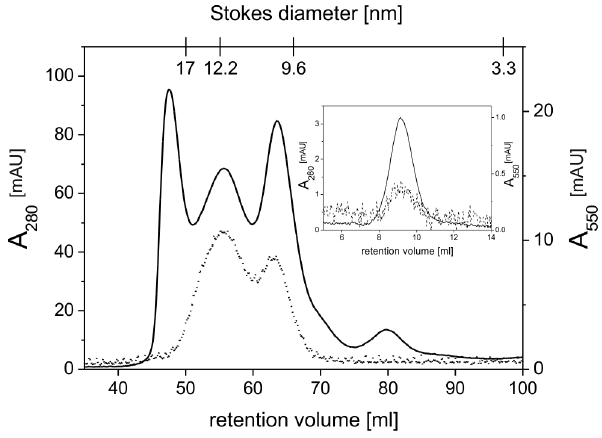
Figure 2. Size exclusion chromatography of bR loaded nanodiscs. Ni-NTA purified bR loaded nanodiscs were run over a HiLoad XK16/600 Superdex 200 column. Fractions containing bR loaded nanodiscs with a Stokes diameter of 12 nm were pooled and reinjected on an analytical Superdex 200 10/300GL column (inset) to verify stability of the bR nanodiscs. Solid and dotted lines show absorbance at 280 nm and 550 nm, respectively.